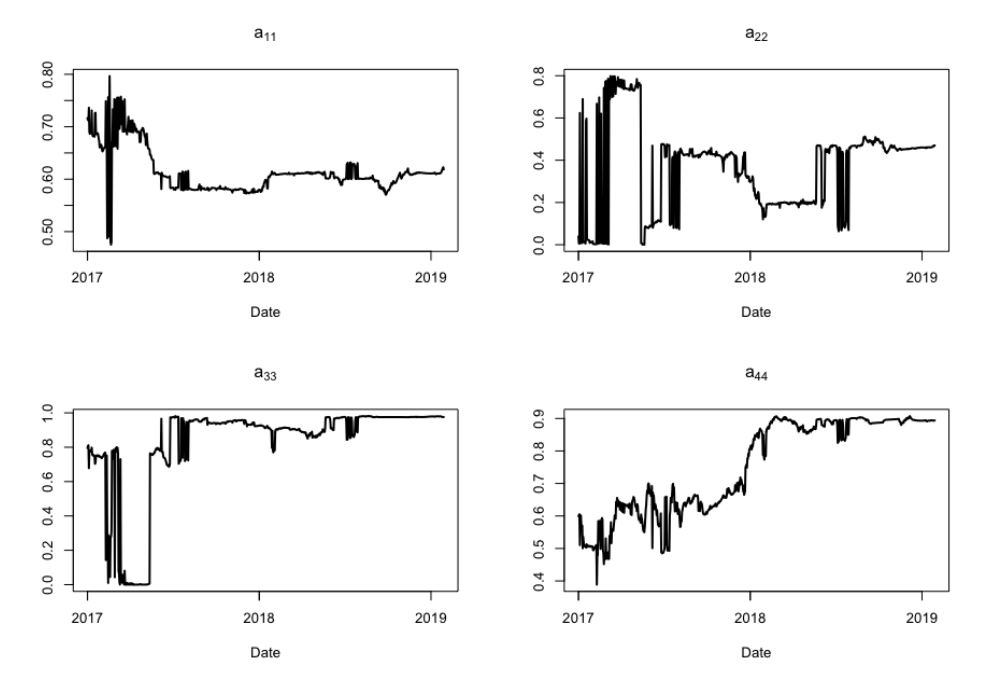
Figure 3. Expanding window: state persistence for the homogeneous four-state normal-HMM on BTC/USD daily log